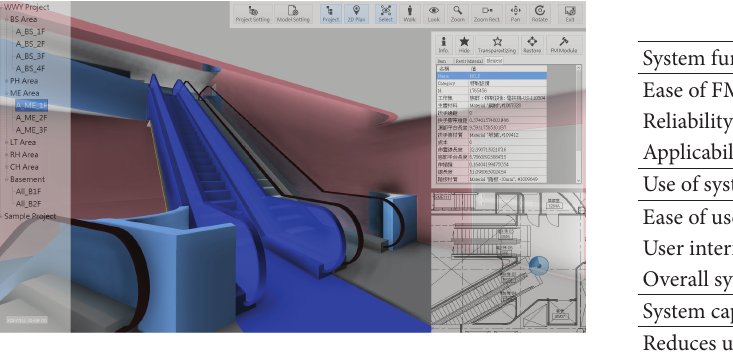
Figure 5: GUI of the BIMFMM system.